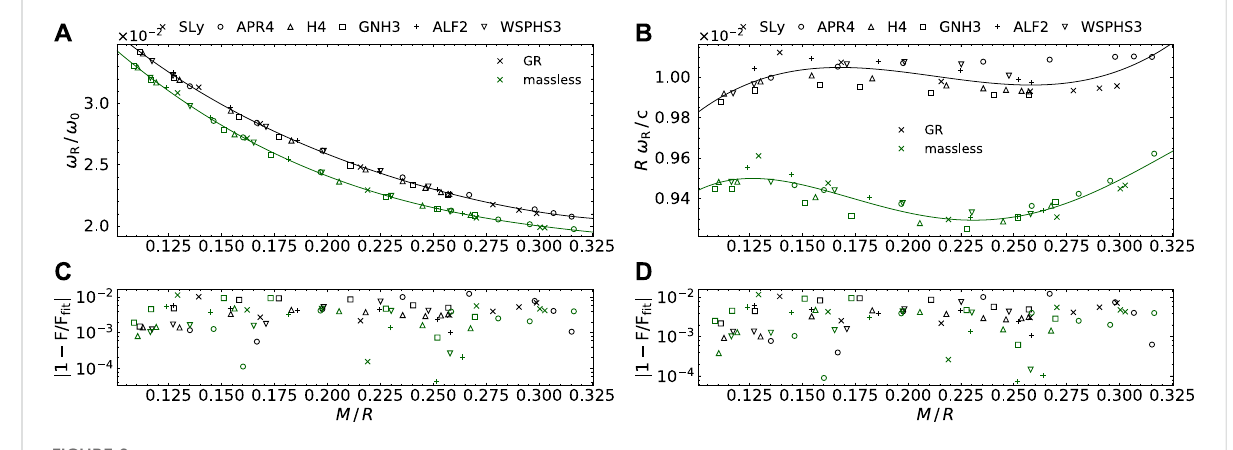
FIGURE 9 Dipole ϕ -mode universal relations: dimensionless frequencies ω R / ω o (A) and R ω R / c (B) and their fi t errors (C,D) versus compactness C = M / R . The symbols indicate the respective equation of state, and the color green indicates the massless case, with the general relativistic case in black.